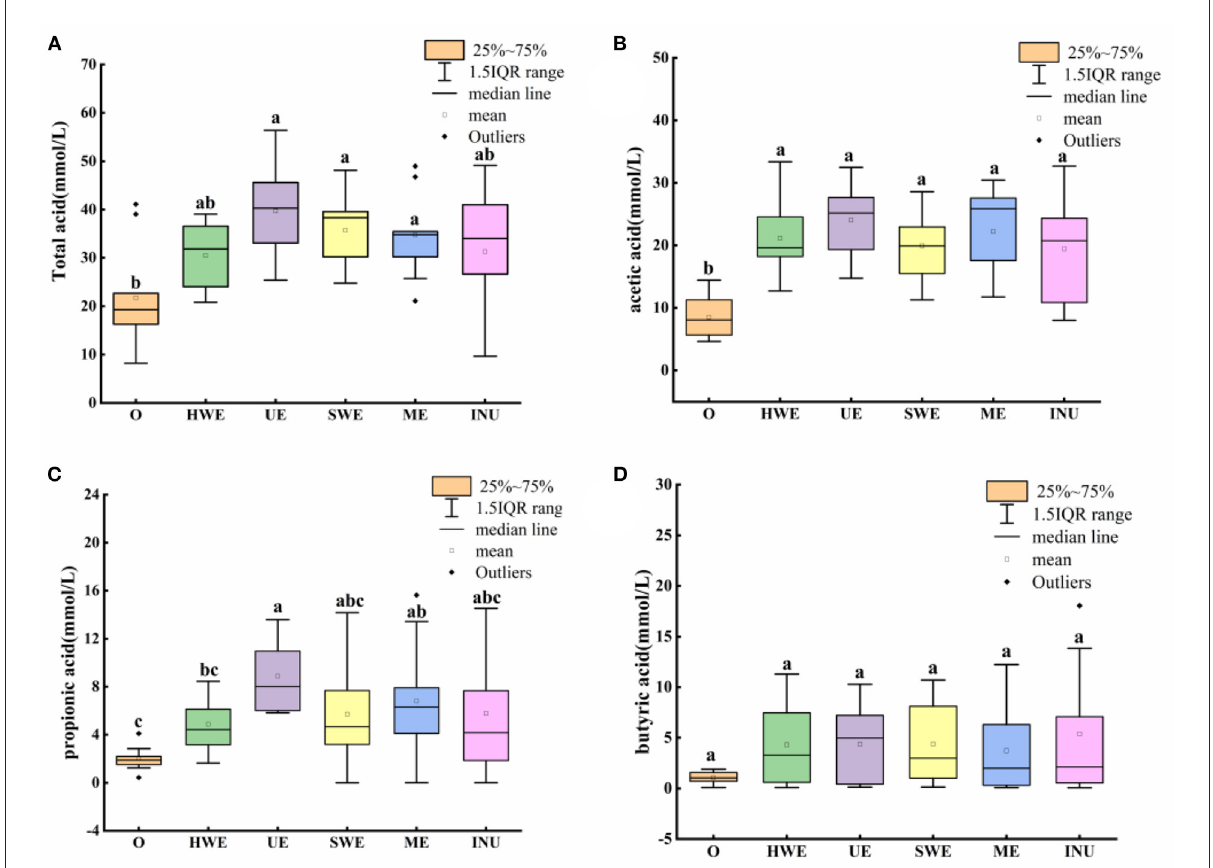
FIGURE3 Short-chain fatty acid content in in vitro fermentation samples. O stands for blank control group. HWE, UE, SWE, and ME stand for dietary fiber extracted with hot water, ultrasonic assisted, subcritical water, and microwave assisted methods, respectively. INU stands for inulin. Different letters a, b and c indicate significant differences ( p < 0.05), the same letters indicate that the differences are not significant ( p > 0.05). (A) Total acid content, (B) acetic acid content, (C) propionic acid content, and (D) butyric acid